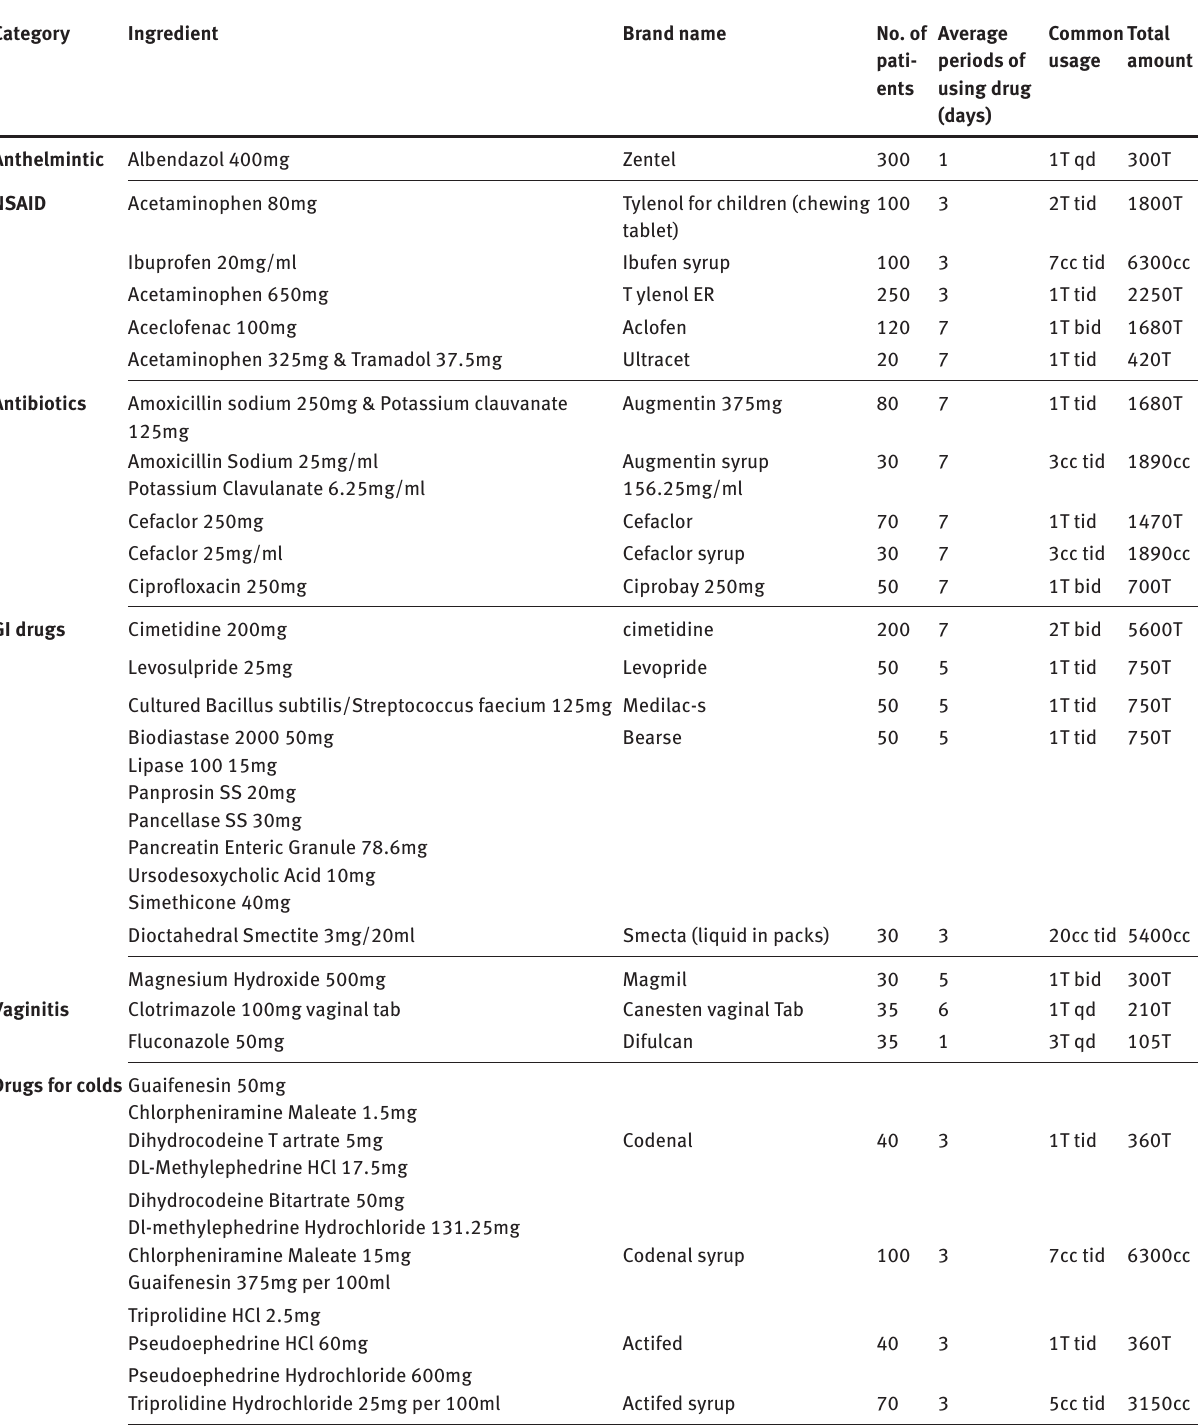
Supplement Table 1. Medicine list of our fifth mission We provide example of medicines list that can be used in medical volunteering. This list of medications is based on anticipated number of 700 patients (based on the largest number of patients in our previous